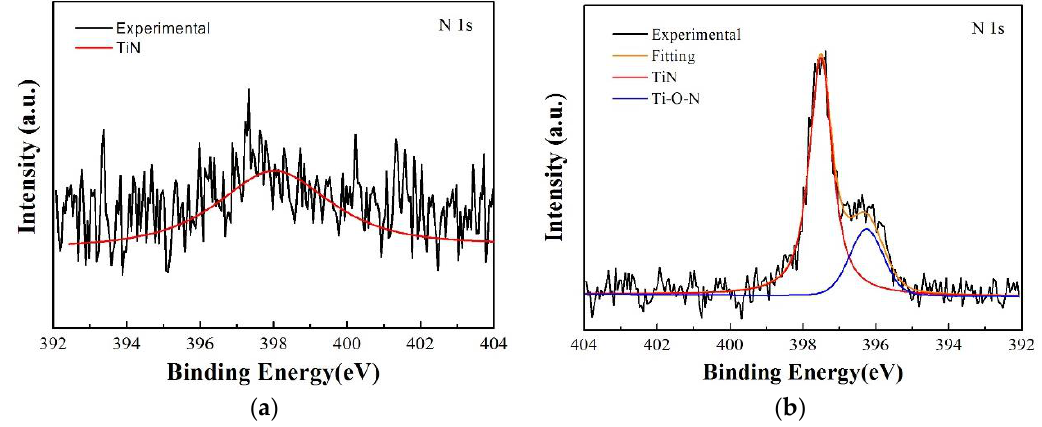
Figure 8. XPS N 1s spectra of the Ti/TiN multilayer film at different normal loads; ( a ) 20 N, ( b ) 100 N.